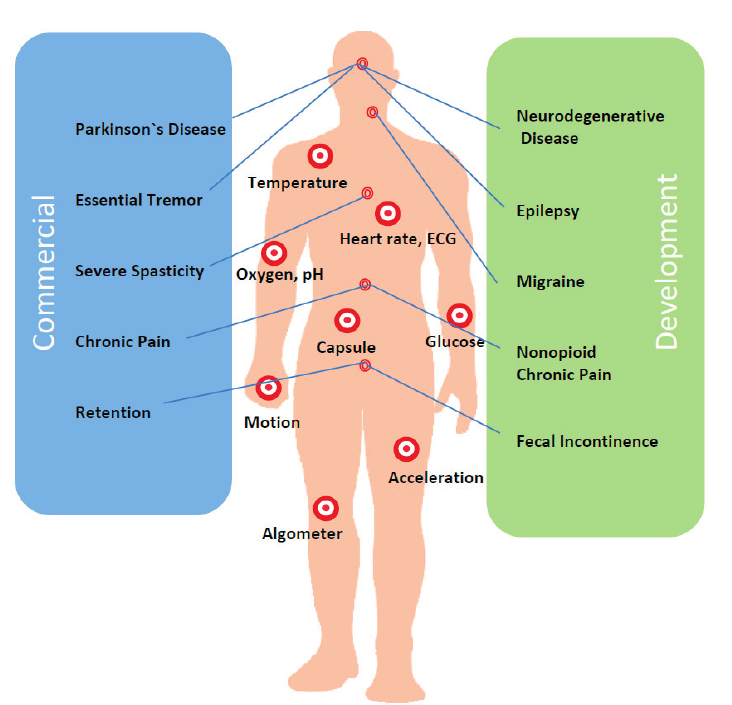
Figure 1. Mapping of implantable devices (based on